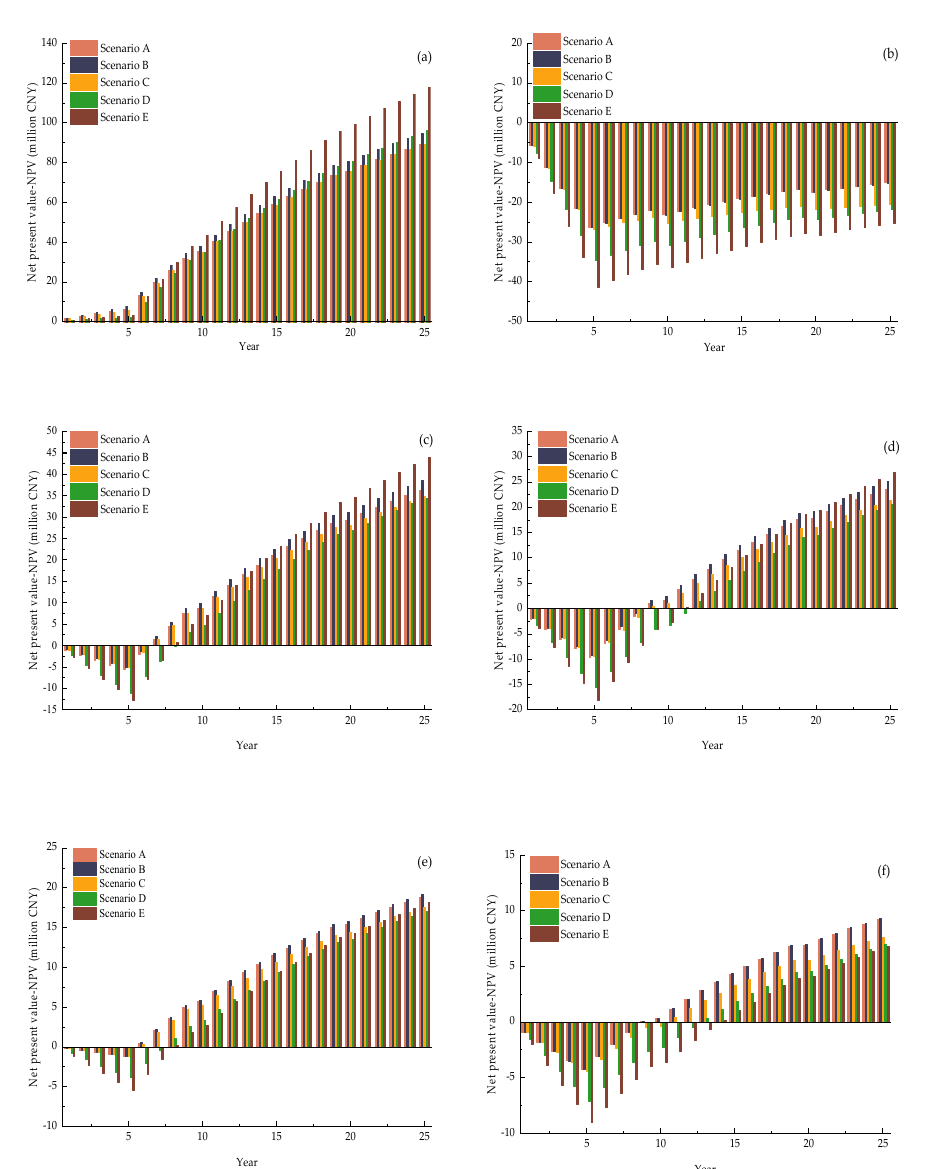
Figure 12. Net present value of PV systems installed on the flat rooftops in the three studied universities under five scenarios: ( a ) “full-self-consumption” mode in Tibet University; ( b ) “full-feed-into-grid” mode in Tibet University; ( c ) “full-self-consumption” mode in Qinghai University; ( d ) “full-feed-into-grid” mode in Qinghai University; ( e ) “full-self-consumption” mode in Qilu University of Technology; ( f ) “full-feed-into-grid” mode in Qilu University of Technology.